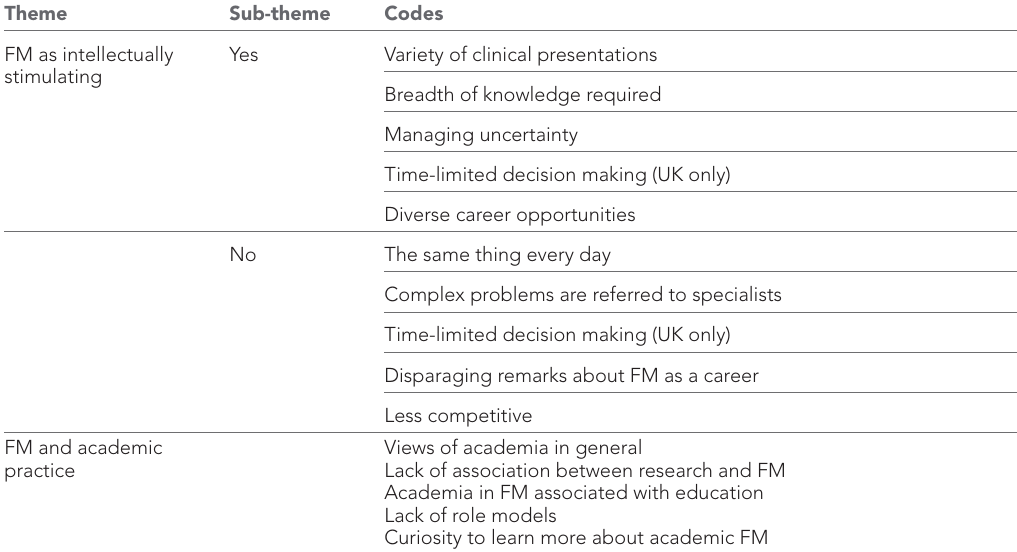
Table 1 Thematic structure, sub- themes, and codes